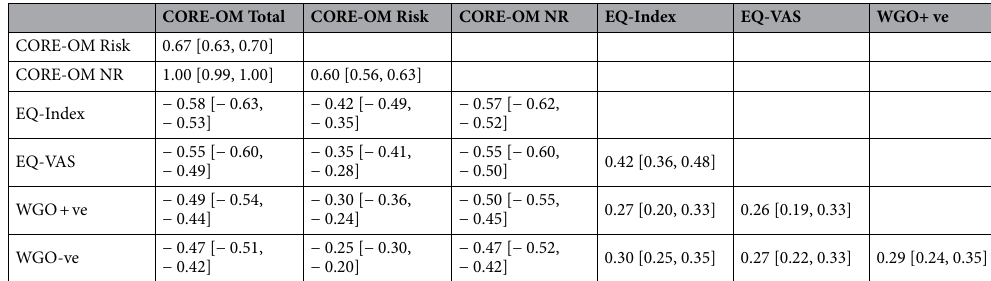
Table 1. Pearson’s correlations and 95% bootstrapped confidence intervals of the dependent variables. CORE-OM Clinical Outcomes in Routine Evaluation, NR Non-risk items score, EQ-Index EuroQol five- dimension-three-level Index, EQ-VAS EuroQol Visual Analogue Scale, WGO+ve What’s Going On score for “good things happened to me these last two months”, WGO−ve What’s Going On score for “bad things happened to me these last two